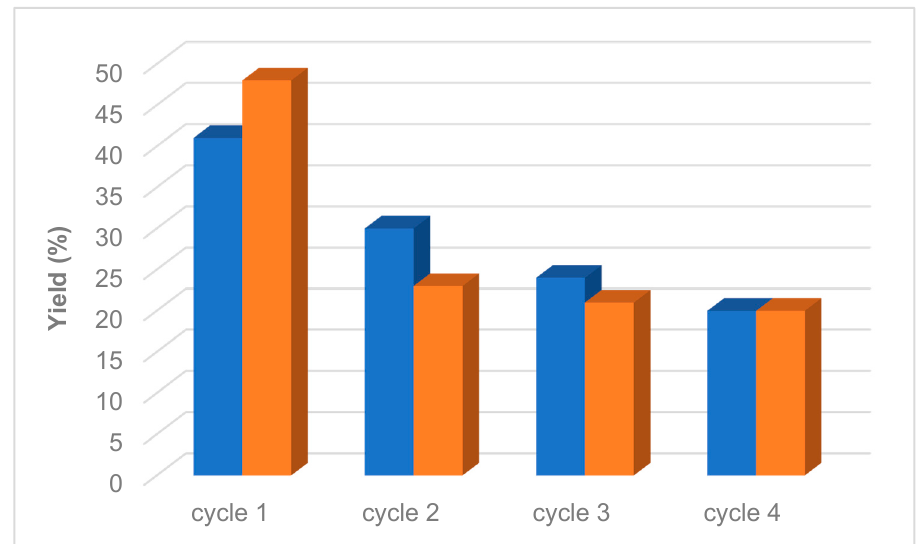
Figure 1. Effect of catalyst recycling on the yield of the product for the MW-assisted synthesis of 1,2,3-triazole catalyzed by 2 _CNT-ox-Na ( ) and 4 _CNT-ox-Na ( ). Reaction conditions: 0.5 mol% of 2 _CNT-ox-Na vs. benzyl bromide, 1.0 mol% of 4 _CNT-ox-Na vs. benzyl bromide, 15 min, 30 W microwave irradiation, 80 °C.